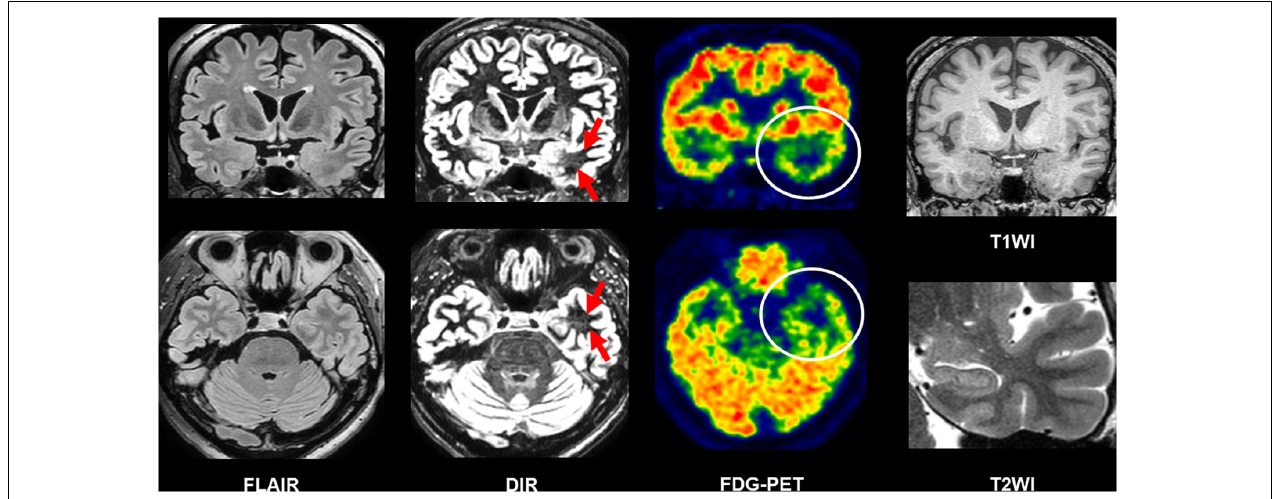
FIGURE 5 | A case of conventionally MRI-negative PET-positive temporal lobe epilepsy (TLE). While it was difficult to detect abnormalities on FLAIR, double inversion recovery (DIR) visualized hyperintensity within the anterior temporal white matter of the focus side. T1-weighted images (T1WI) and T2WI were also intact including the hippocampus.